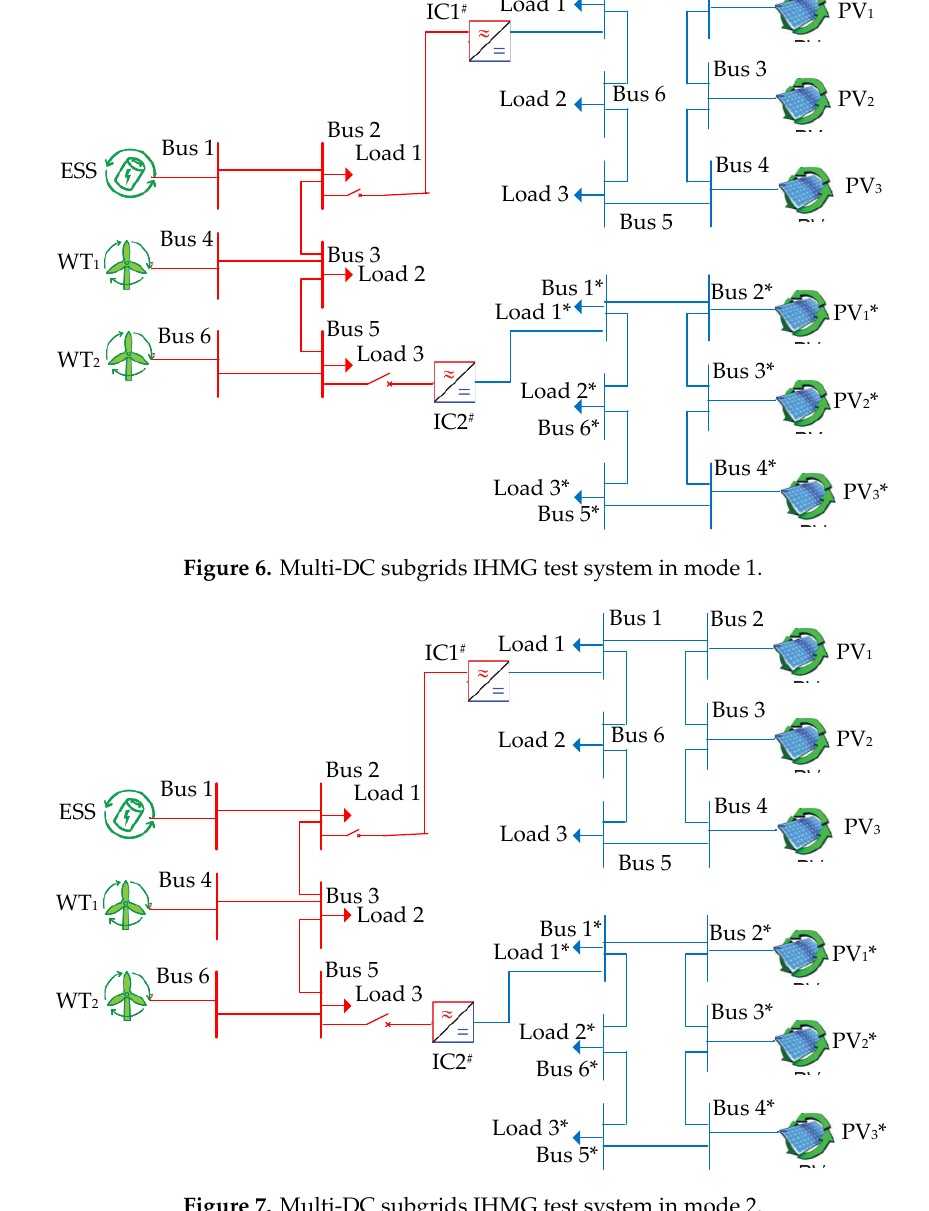
Figure 7. Multi-DC subgrids IHMG test system in mode Figure 6. Multi-DC subgrids IHMG test system in mode 1.